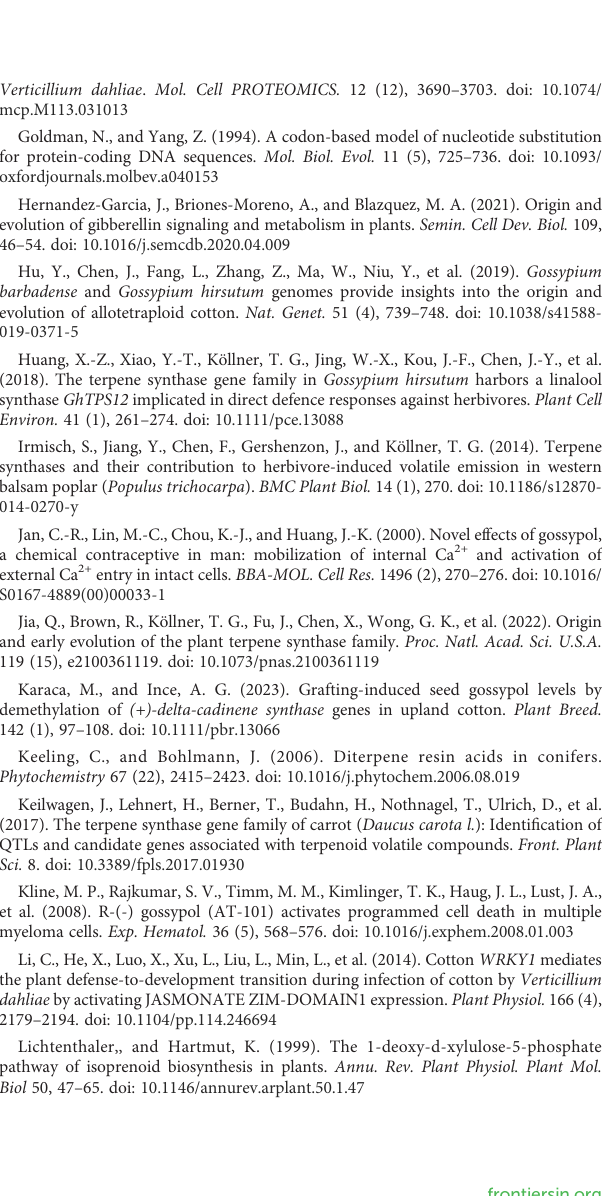
SUPPLEMENTARY FIGURE 4 The gene structure of GhCDN-A. The left was the GhCDN-A gene phylogenetic tree, the right was the gene structure, the green was the exon, the line was the intron, the blue was the untranslated region (UTR) and the length was the relative length of the gene. SUPPLEMENTARY FIGURE 5 Heatmap of the expression level of GhCDNs in different tissue. The relative expression of GhCDNs in allotetraploid cotton ( Gossypium hirsutum L . acc. TM-1) based on a previous report. SUPPLEMENTARY FIGURE 6 Knockdown several key genes/cluster of GhCDN-A subfamily. Heat map of FPKM of 12 GhCDNA genes in eight high gossypol and two low gossypol varieties. (A) The silencing ef fi ciencyof GhCDNA1 or GhCDNA5 genes silencing plants. (B) The density of glands of leaves on GhCDNA1 or GhCDNA5 genes silencingplants. (C) Thephenotypesof GhCDNA1 or GhCDNA5 genessilencing plants. (D) Thesilencingef fi ciencyofthree GhCDN-A geneclusters.ThegroupI gene cluster contained GhCDNA3, GhCDNA4, GhCDNA11, GhCDNA10, GhCDNA8, GhCDNA12 . The group II contained GhCDNA1, GhCDNA5. The group III contained GhCDNA2, GhCDNA6, GhCDNA7 , and GhCDNA9. (E) The densityofglandsofleavesonthree GhCDN-A geneclusterssilencingplants. (F) The phenotypes of leaves on three GhCDN-A gene clusters silencing plants.